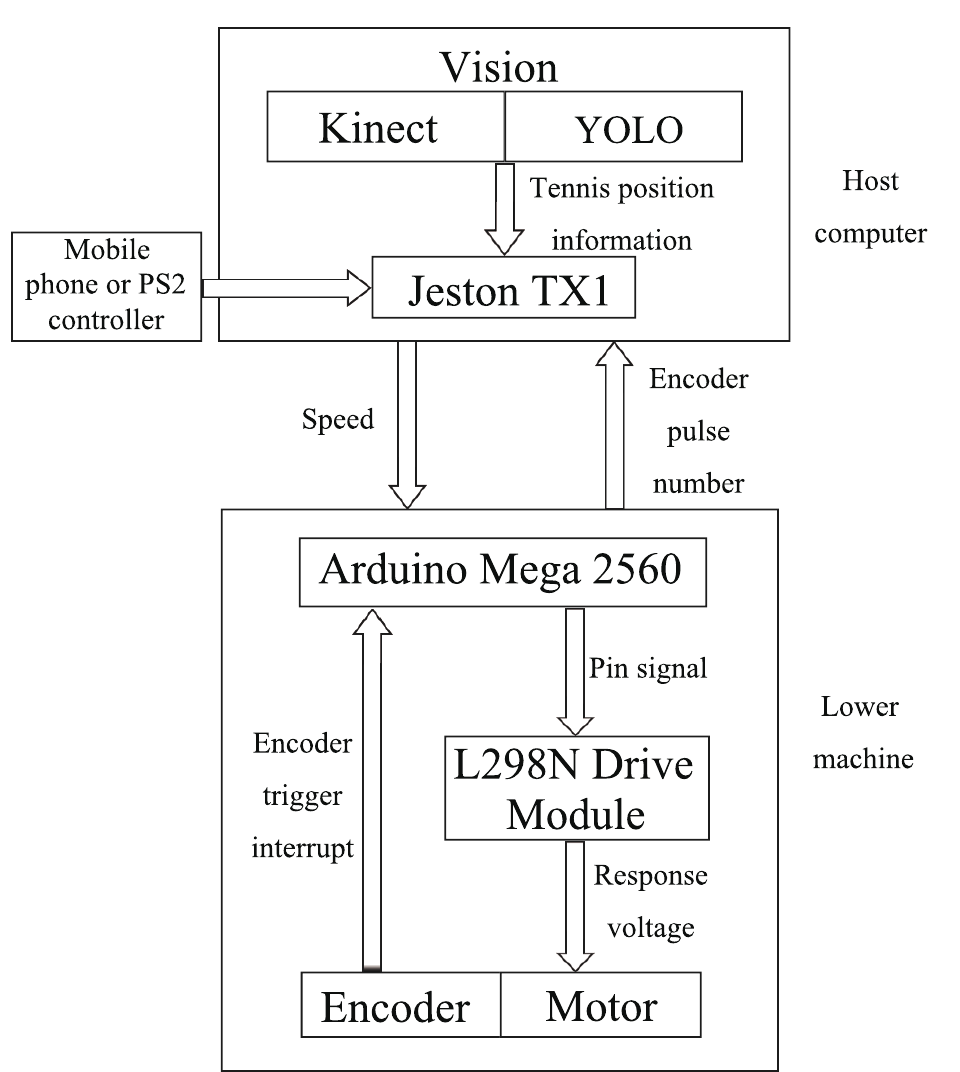
Figure 1. Structural block diagram of tennis